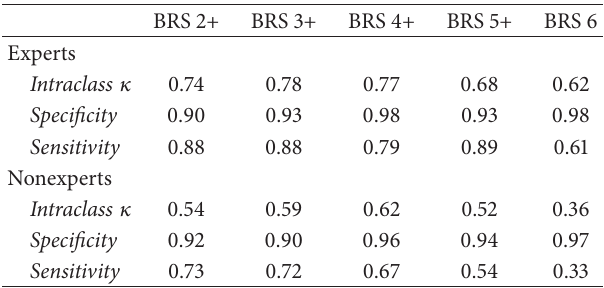
Table 5: Averaged intraclass kappa ( 𝜅 ), sensitivity, and specificity for experts and nonexperts by scale